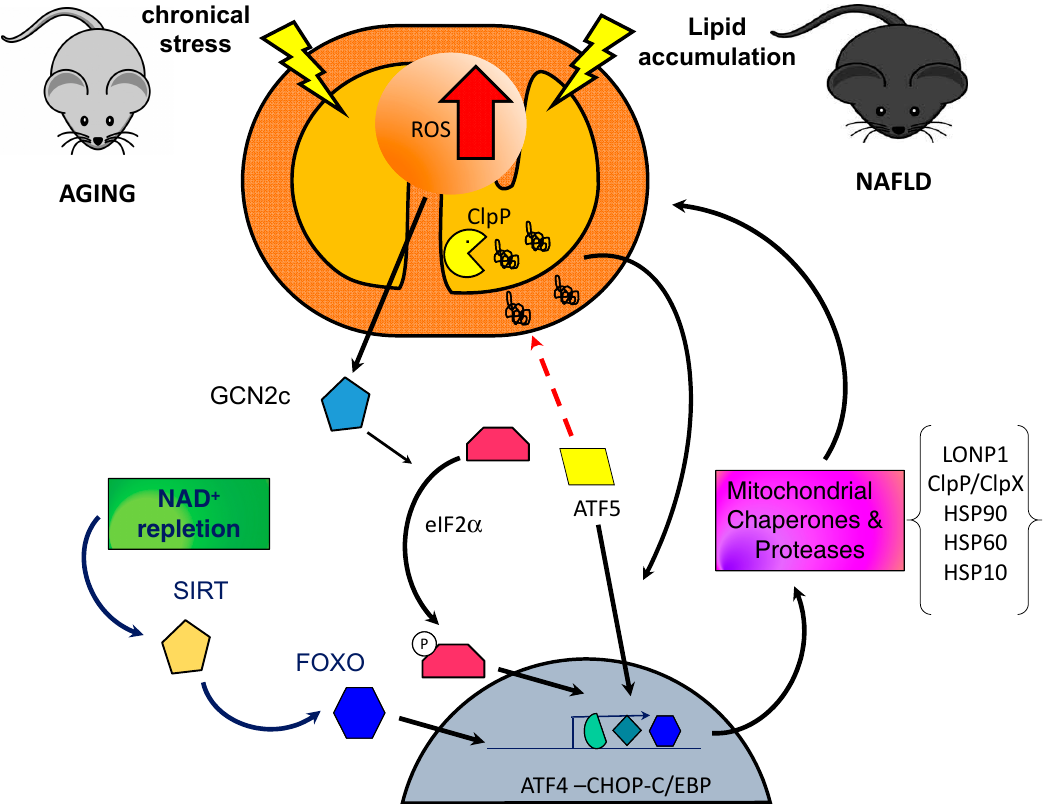
Figure 1. Proposed model of mitochondrial unfolded protein response (UPR mt ) increased activation in non-alcoholic fatty liver disease (NAFLD) and Sarcopenia. The mechanisms that regulate the activation of UPR mt are still unveiled and are probably determined by the stress conditions present in the cell environment in a context-dependent way. Lipid accumulation in the liver and the presence of chronical stress during the aging process in skeletal muscle cells promote an increase in mitochondrial reactive oxygen species (ROS) production which triggers the phosphorylation of eukaryotic translation initiation factor 2 alpha (eIF2 α ) to trigger the integrated stress response (ISR). Moreover, the accumulation of misfolded and oxidized proteins which cannot be degraded inside the mitochondria by mitochondrial proteasespromotesthetranslocationofactivatingtranscriptionfactor5(ATF-5)tothenucleus, increasing the transcription of mitochondrial chaperones and proteases. The prolonged exposure to the stress may continuously stimulate the response enhancing its e ff ect until making it detrimental for the